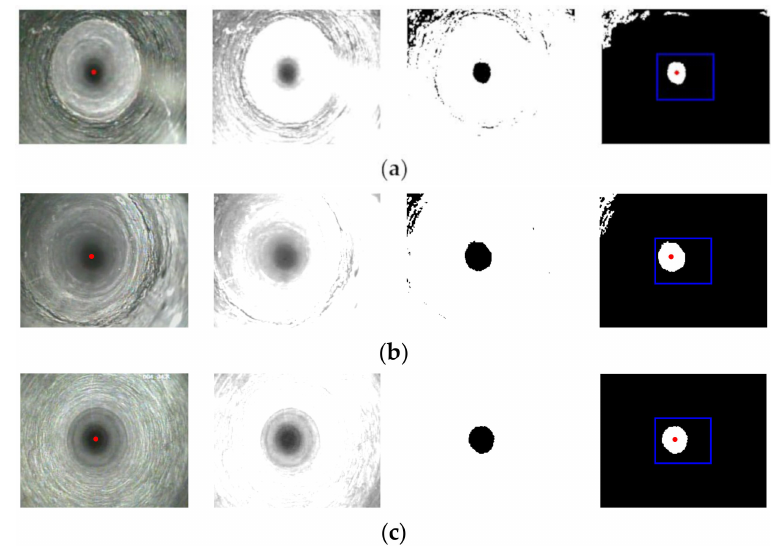
Figure 14. The center location for three types of borehole-wall images. ( a ) Process of center positioning for border image; ( b ) process of center positioning for fracture image and ( c ) process of center positioning for intact rock mass image.